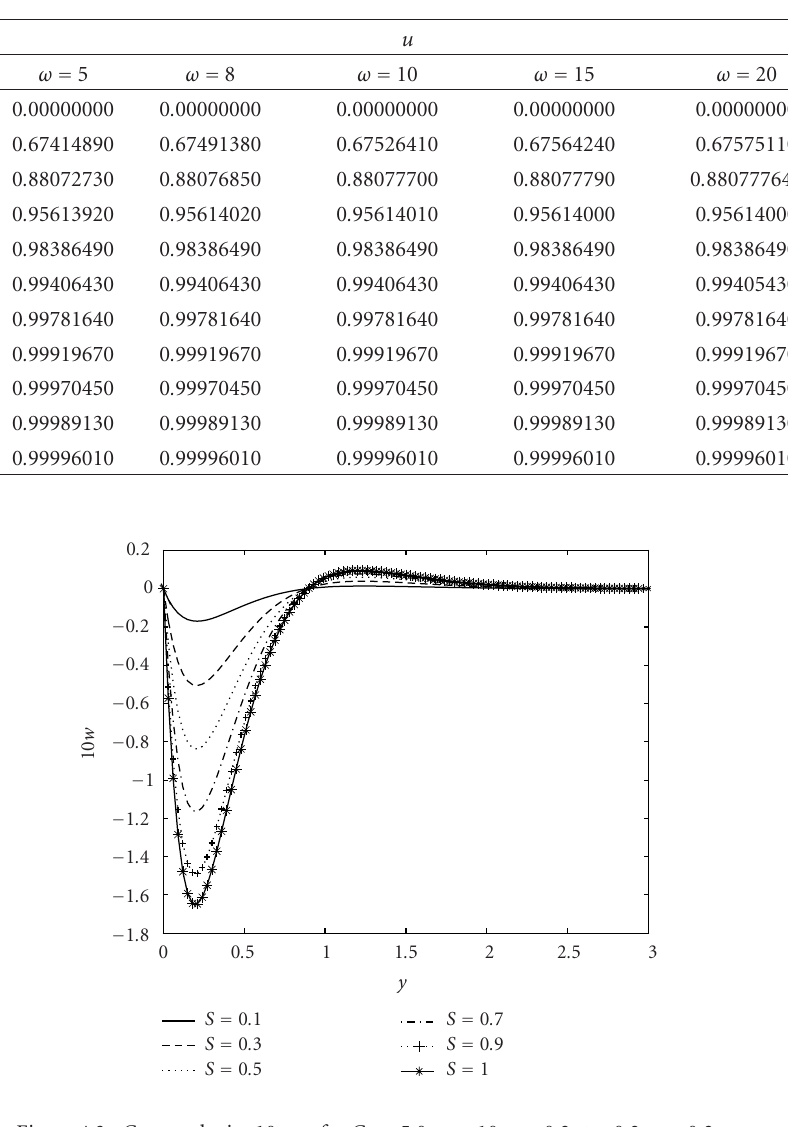
Figure 4.3. Cross-velocity 10 × w for Gr = 5 . 0, ω = 10, z = 0 . 2, t = 0 . 2, (cid:2) = 0 .